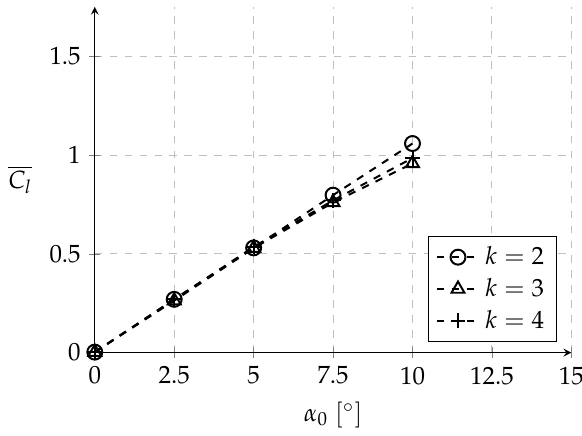
Figure 13. Mean lift coefficient as a function of α 0 at St =